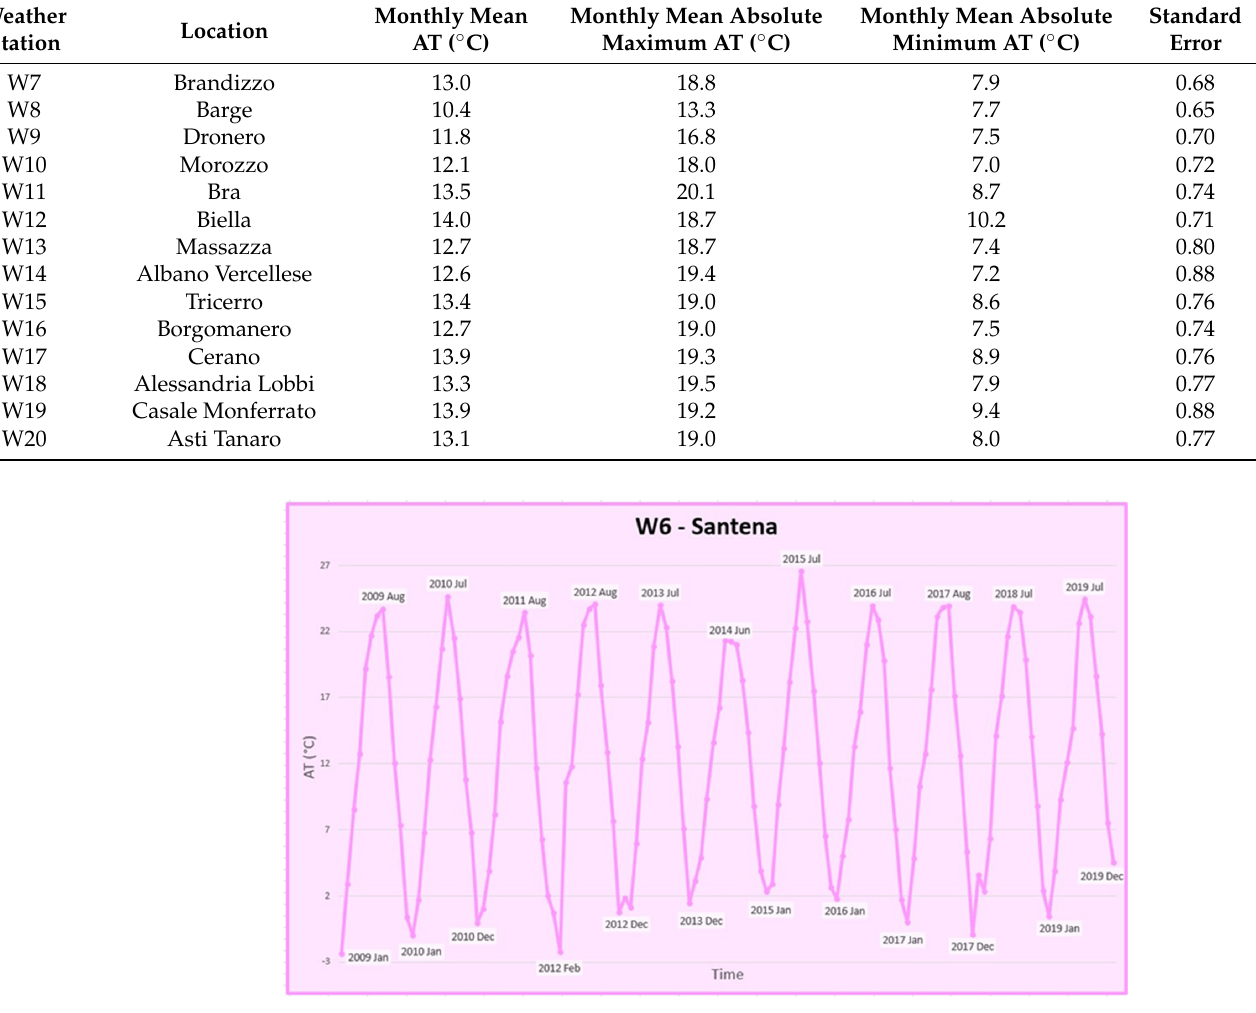
Figure 4. Example of maximum and minimum AT peak behaviour observed in the weather stations. Table 3. Nonparametric test analysis results for